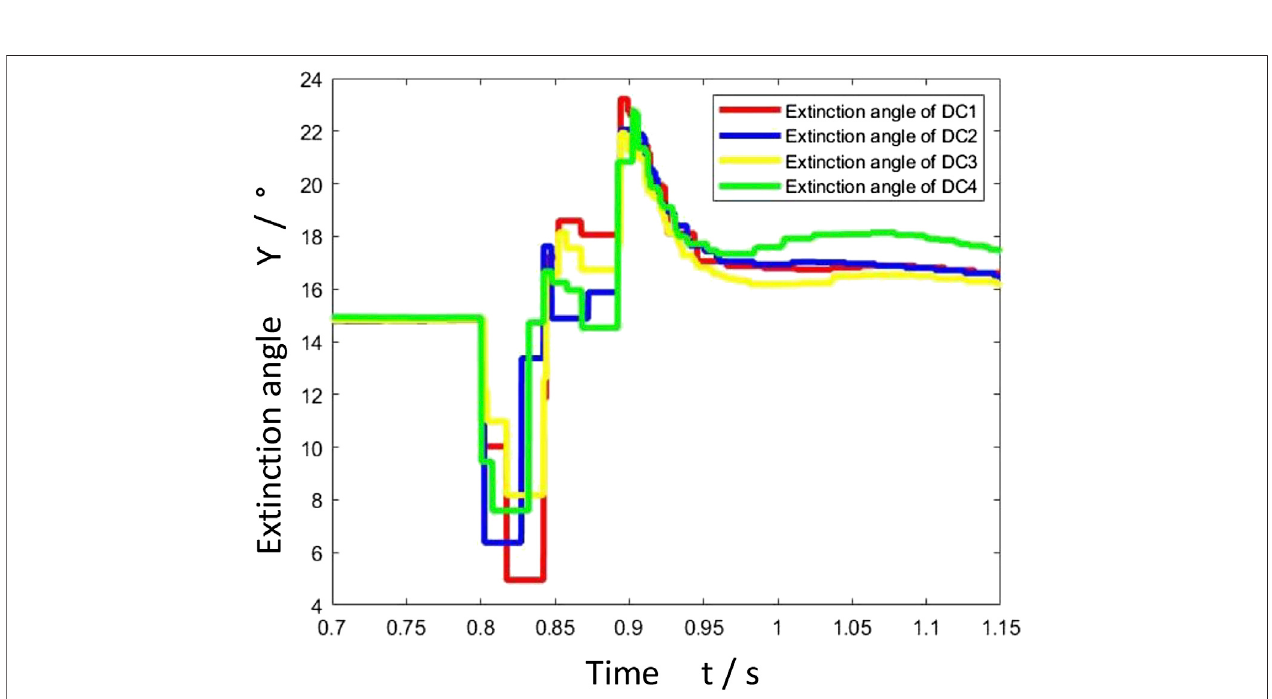
FIGURE 6 | Extinction angle of four converter